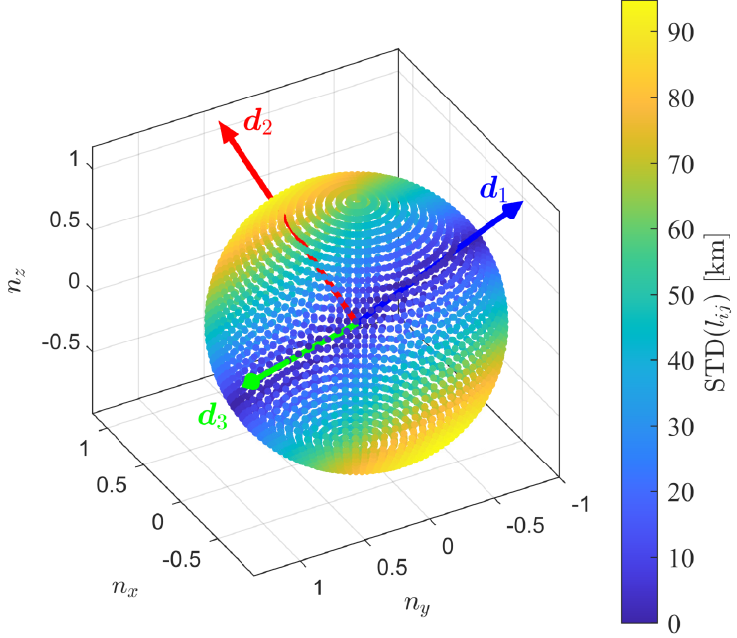
Figure 9. The effects of the velocity insertion errors of SC1 on the configuration stability. d 1 , d 2 and d 3 respectively represent the radial, the tangential and the normal directions.